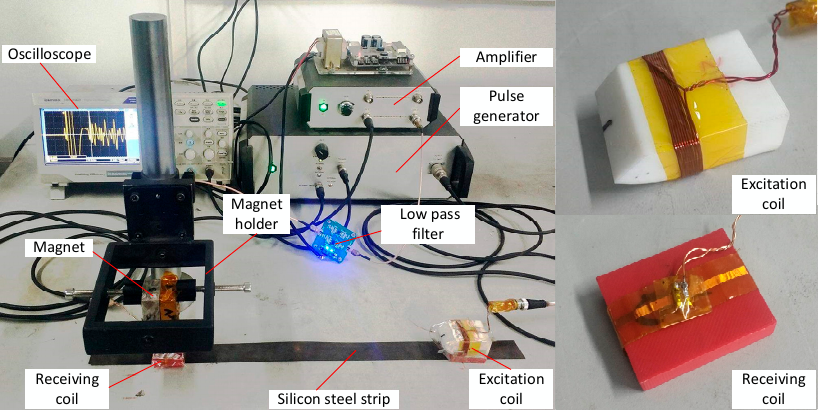
Figure 8. Instrumental setup.